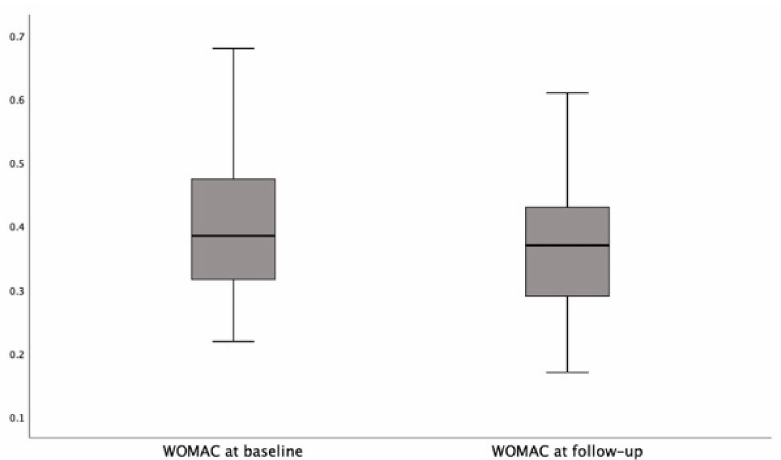
Figure 3. The follow-up WOMAC scores in participants on FEHC diet.